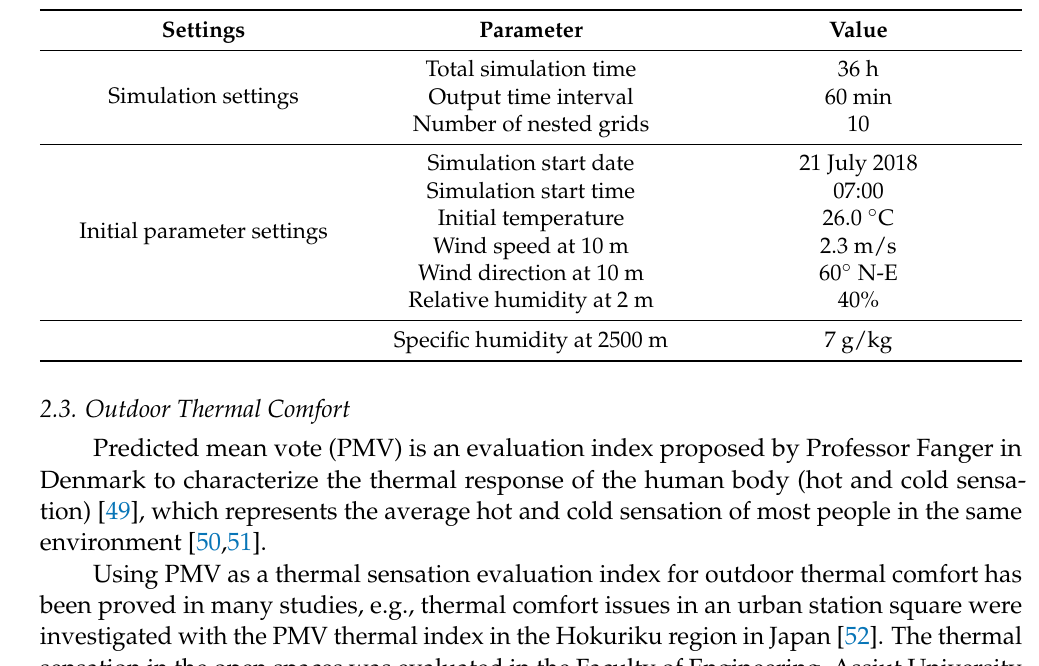
Table 2. Basic meteorological parameters and values during the